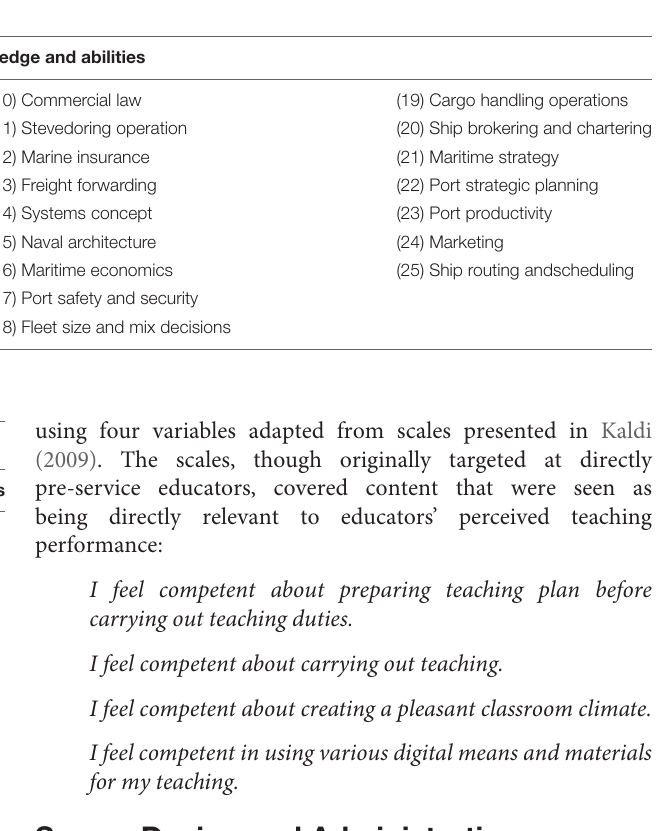
TABLE 2 | Maritime competencies.